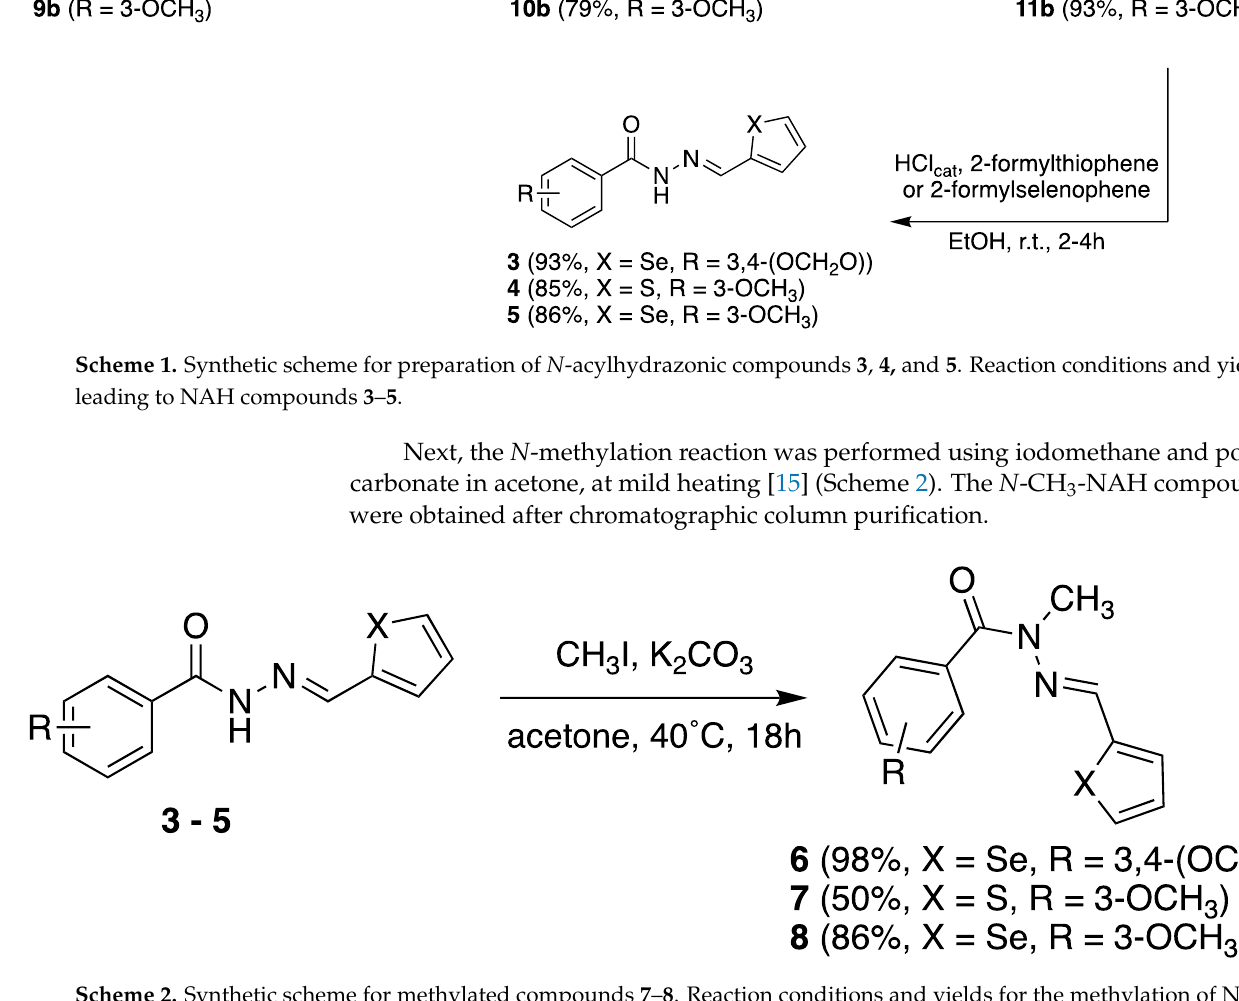
Table 1. 1 H-NMR (400 MHz, DMSO- d 6 , 25 °C) shifts of compounds 1 – 8 . Comparison between the hydrogens H-3, H-4, H-5 of the heterocycles, iminic, and amidic hydrogens in NAH-derivatives 1 – 8 , demonstrating the deshielding in sele- nophene isosters.